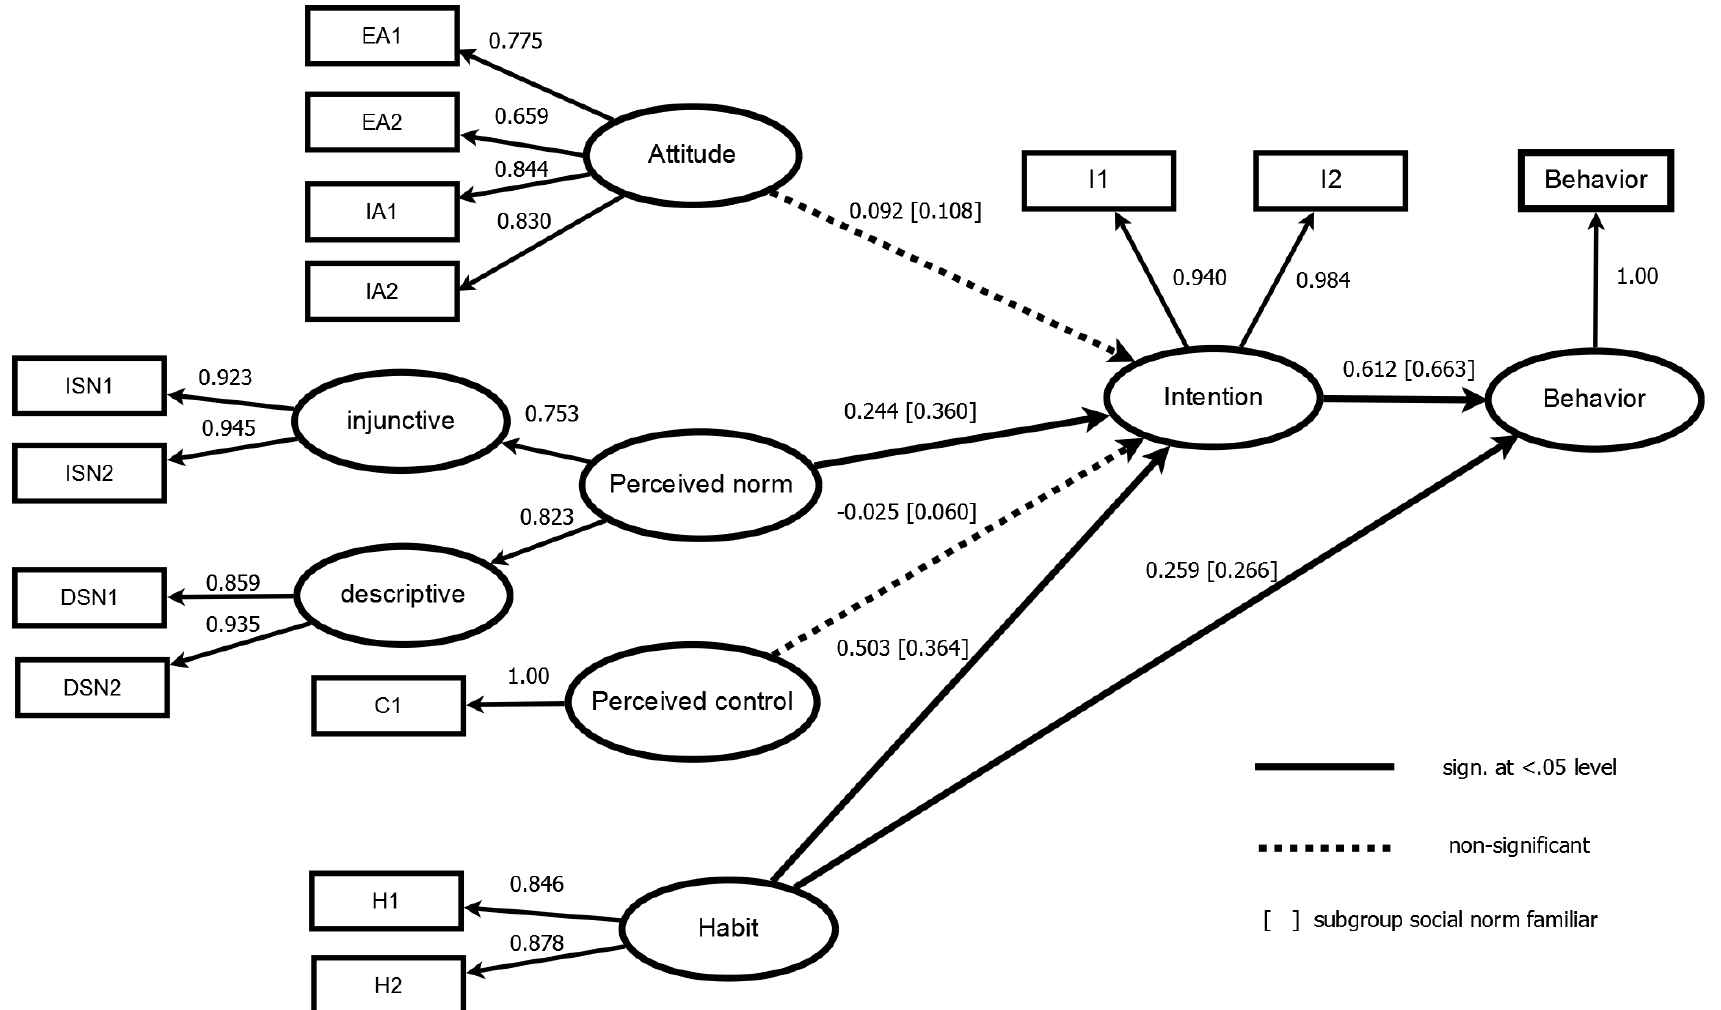
Figure 2. Structural equation model international teleconferencing (standardized loadings and path